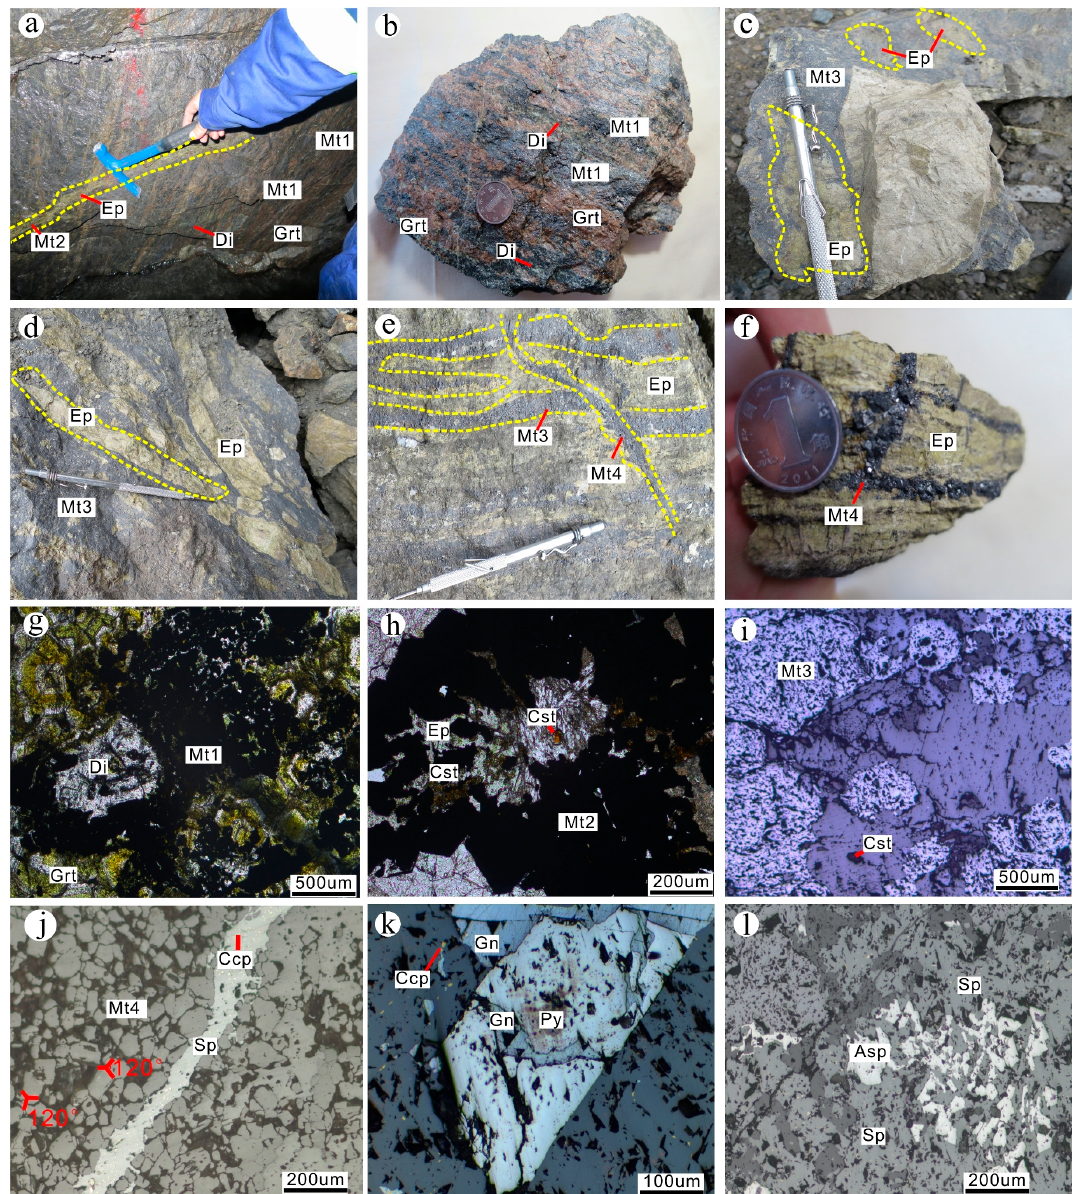
Figure 3. Mineral assemblages of the Huanggangliang Sn-Fe deposit. ( a ) Epidote skarn vein bearing disseminated magnetite (Mt2) cutting through banded garnet–diopside–magnetite (Mt1) ore body; ( b ) banded garnet–diopside–magnetite (Mt1) ore; ( c ) fine-grain massive magnetite (Mt3) cements epidote skarn bearing disseminated magnetite (Mt2); ( d ) fine-grain magnetite (Mt3) cements epidote skarn lenticles bearing dissminated magnetite(Mt2); ( e ) coarse-grain massive magnetite cutting through epidote skarn bearing disseminated magnetite(Mt2) which is cemented by fine-grain massive magnetite (Mt3); ( f ) coarse-grain massive magnetite vein (Mt4) cutting through epidote skarn containing disseminated magnetite; ( g ) xenomorphic magnetite replacing garnet and diopside, and later replaced by cassiterite; ( h ) xenomorphic magnetite replacing epidote and later replaced by cassiterite; ( i ) cassiterite, magnetite, and quartz assemblage; ( j ) magnetite occurring with idiomorphic texture, with inter-granule angels of 120°, showing typical triple junction texture. Intersection and cutting of later chalcopyrite-sphalerite; ( k ) galena replacing hypidiomorphic pyrite; ( l ) sphalerite replacing arseno-pyrites. Grt—garnet; Di—diopside; Ep—epidote; Mt—magnetite; Cst—cassiterite; Ccp—chalcopyrite; Sp—sphalerite; Gn—galena; Py—pyrite; Asp—arsenopyrite.